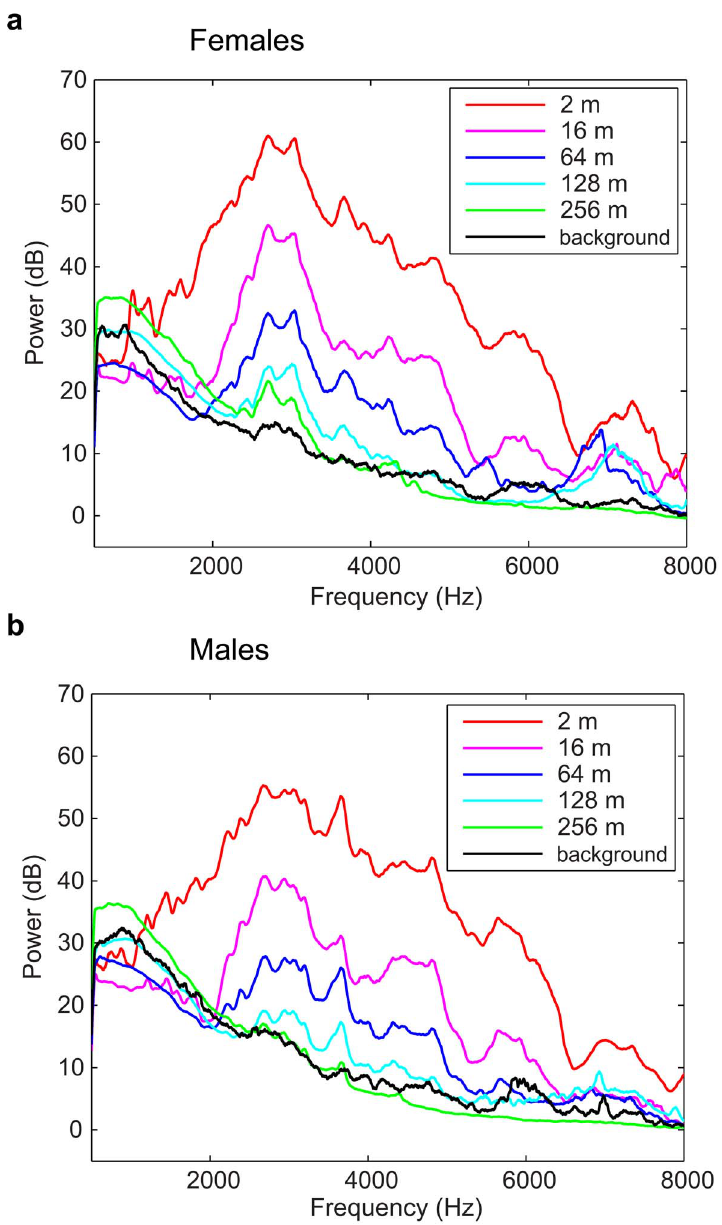
Figure 4. Frequency power spectra of calls at every propagation distance (from 2 m to 256 m). These were calculated using all female (a) and male (b) distance calls recorded in France. The frequency spectrum of the background noise at the recording sites is shown in black. This curve was obtained by averaging the noise spectrum across all recording sites and can therefore be slightly higher than the noise floor at particular distances, as it can be observed for the lower frequency range.